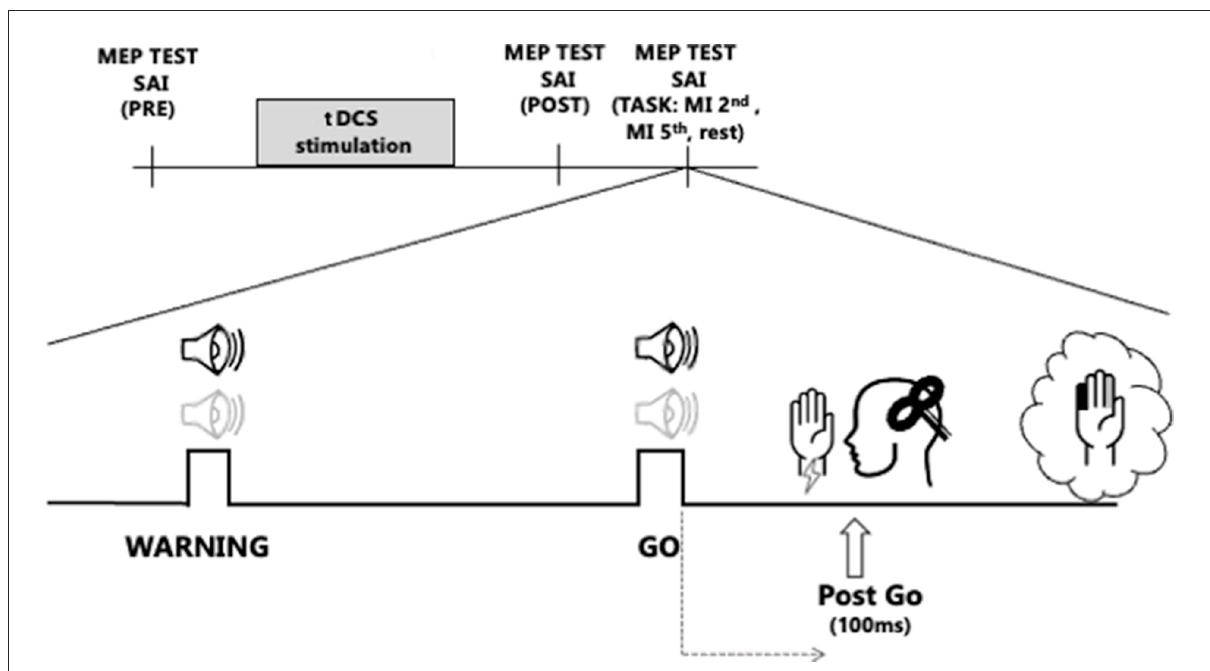
FIGURE1 Experimental protocol. The transcranial direct current stimulation (tDCS) stimulation block represents the two stimulation protocols, anodal tDCS (a-tDCS) or sham tDCS (s-tDCS), delivered before the RT task, over M1. Sound icons represent Warning and Go cues. The light gray audio symbol represents the tone for the 2nd finger imagined abduction, while the black stands for the 5th finger abduction. Vertical bar indicates the testing times of short latency afferent inhibition (SAI) from the first dorsal interosseus muscle, before tDCS (SAIpre), after tDCS (SAIpost), and 100ms after the Go signal (Post-Go) in the following conditions: at rest (Rest) and during imagined movement of the 2nd and the 5th finger (2nd finger MI, 5th finger